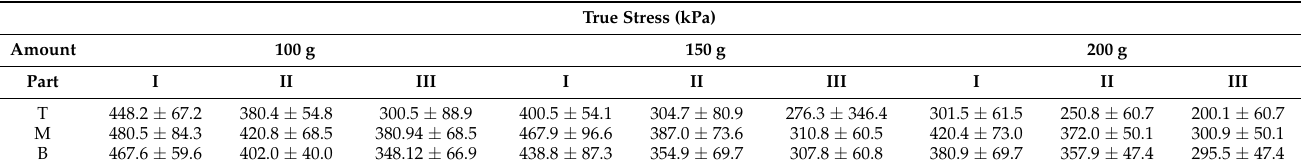
Table 2. True stress (kPa) measured using the compression test of sterilized BF. T, M, and B correspond to the top, middle, and bottom, respectively, in Figure 2b for the sampling location in a stand-up pouch.